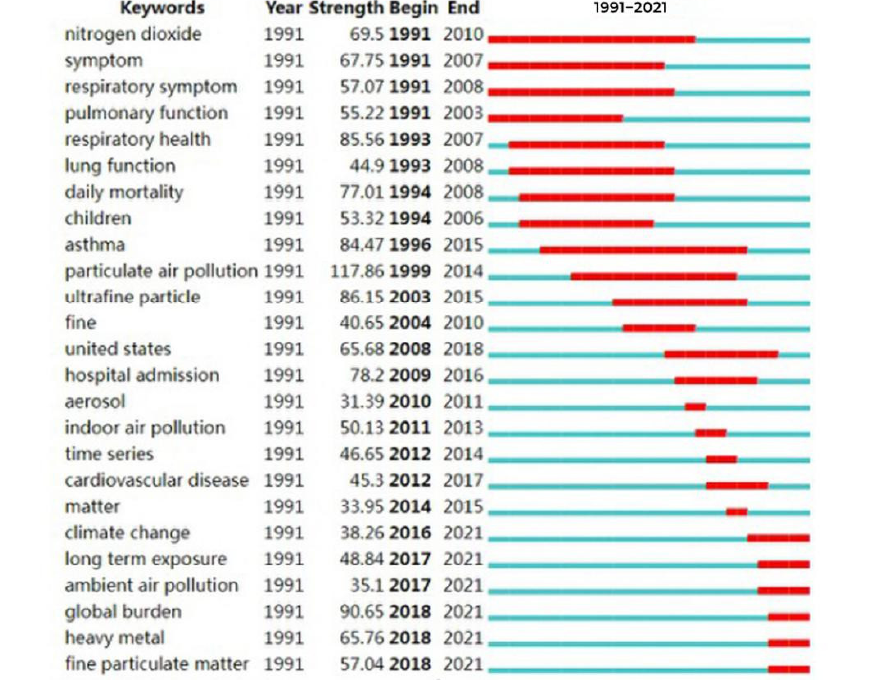
Figure 11. English literature keyword